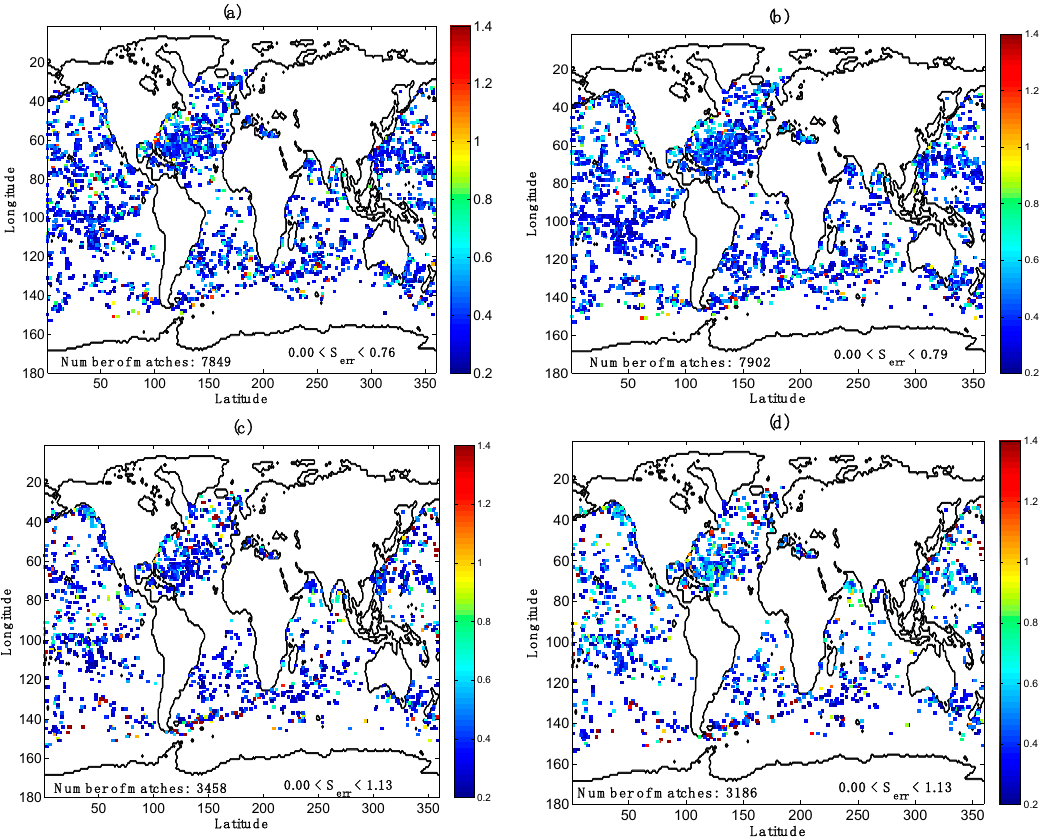
Figure 5. Maps of the buoy pixel point RMSE for the retrieval of: ( a ) TTLS+CEM; ( b ) MTLS+CEM; ( c ) OPR4 (MQL = 5); and ( d ) OPR11 (MQL = 5).